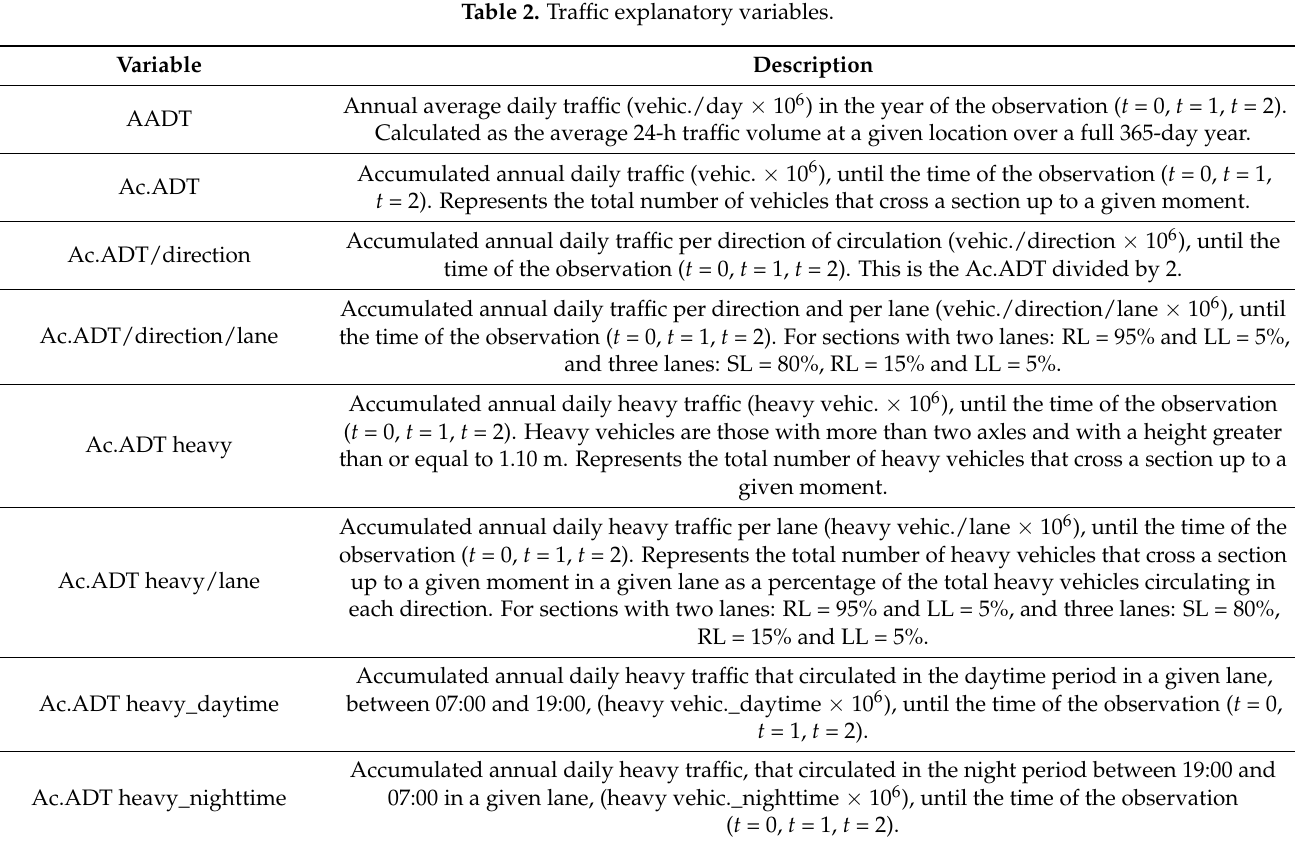
Table 2. Traffic explanatory